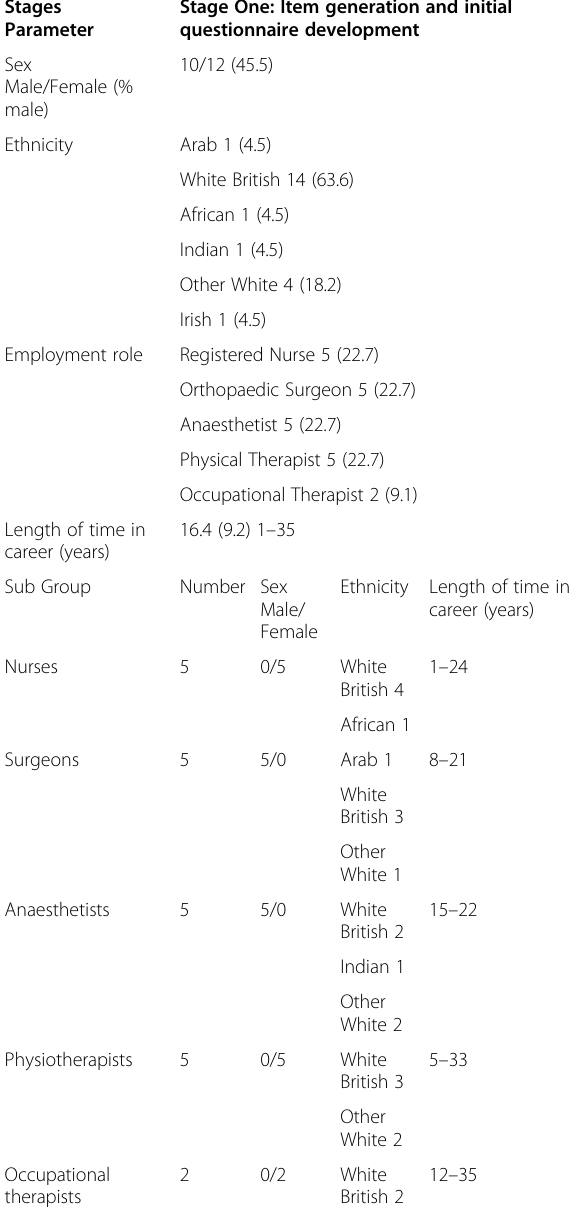
Table 2 Planning phase participant characteristics Stages